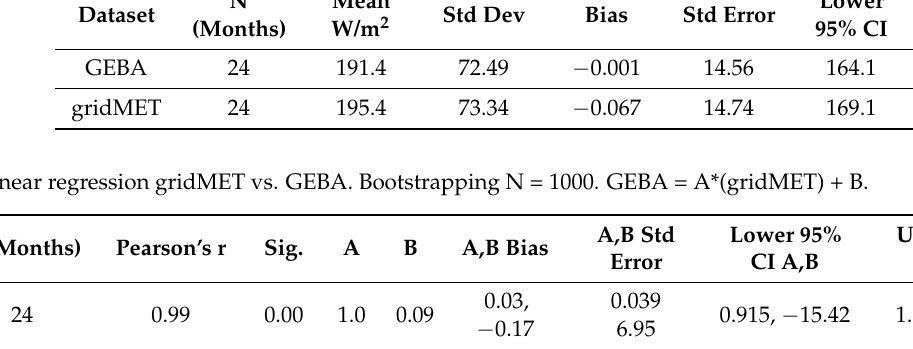
Table 2. Descriptive statistics of overlap months (1979–94) of GEBA and gridMET K ↓ (W/m 2 ). Dataset